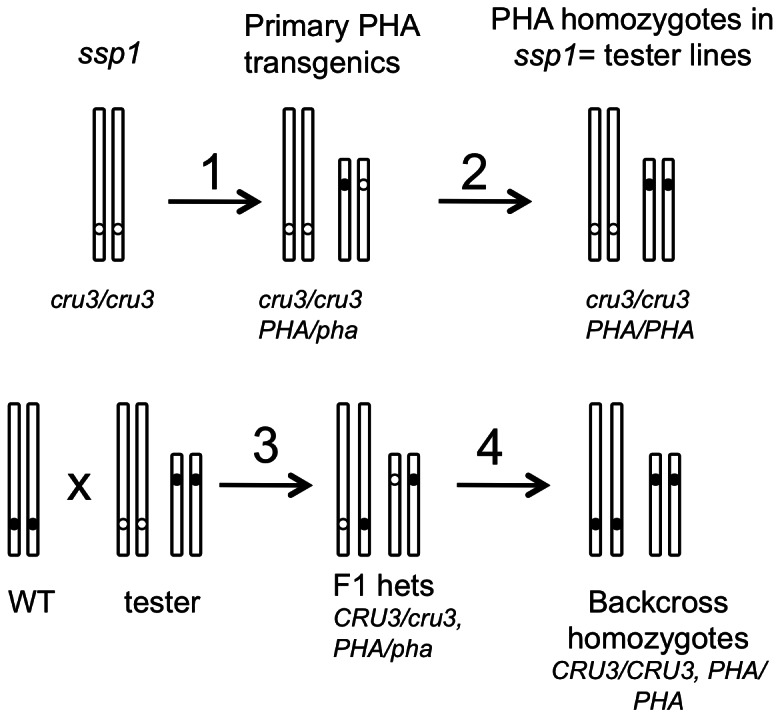
Strategy for testing the empty container hypothesis.Homozygous ssp1 mutants were transformed with a PHA transgene and single copy insertion lines were selected by Southern blotting (step 1). The primary transgenic lines were selfed and homozygous tester lines were selected by examination of SDS-PAGE profiles of seed extracts (ssp1 pattern) and 100% hygromycin segregation in the T3 lines (step 2). The tester lines were crossed to wildtype with the resulting F1 plants being both heterozygous for CRU3 (ssp1) and for the PHA transgene (step 3). Selfing was conducted and F3 lines screened by SDS-PAGE for normal seed protein profiles, by sequencing of CRU3 to determine homozygosity, and by hygromycin segregation to determine PHA homozygosity (step 4). The resulting tester and backcross lines are homozygous for a single PHA insertion such that reporter gene copy number and context are fixed in both the tester (cru3 background) and the wildtype (CRU3) background.